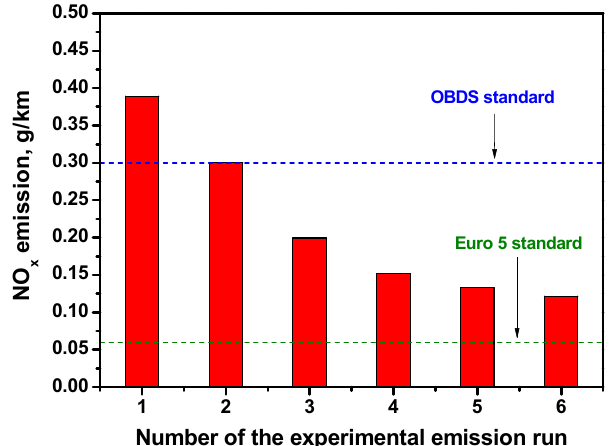
Figure 1. Results of the consecutive roll emission tests on Lada Vesta automobile with a rapidly aged OBD catalyst.